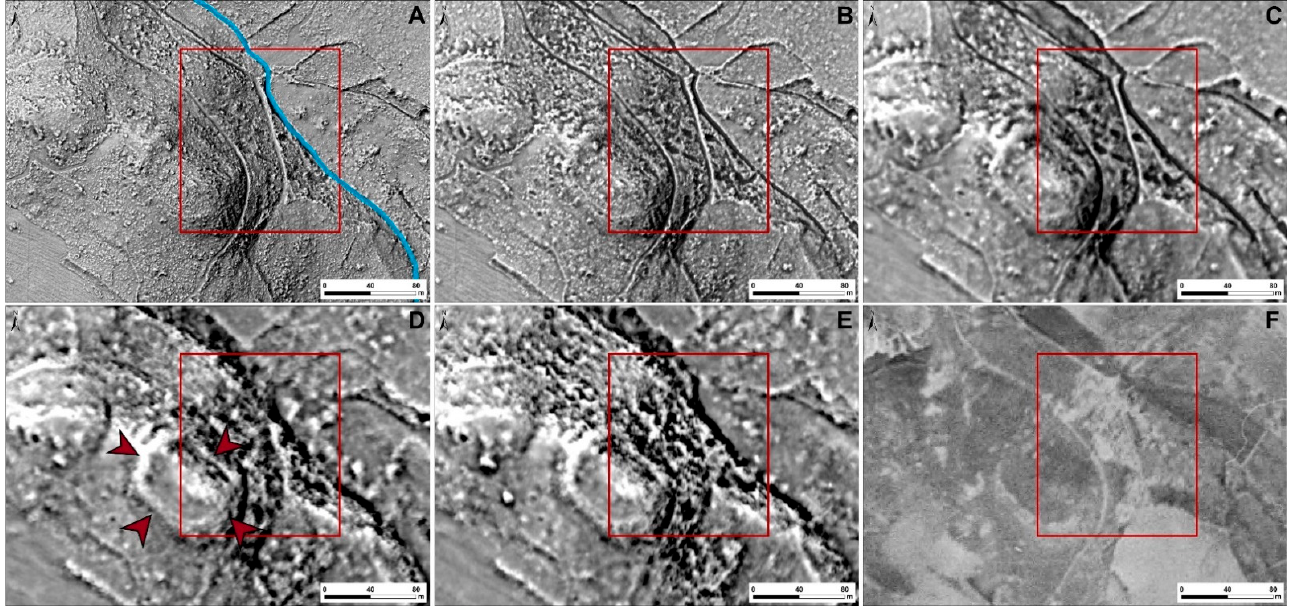
Figure 5. Outeiro de Baltar hillfort with the area explored by the Somar company highlighted (red square). Note the main visible rampart of the hillfort (of near-circular shape depicted in image ( D ) and the mining trenches near the Ferradal stream (the stream is depicted in blue in image ( A ), which affected part of the hillfort. ( A ) A 0.25 m drone-derived local relief model; ( B ) A 0.50 m drone-derived local relief model; ( C ) A 1 m drone-derived local relief model; ( D ) A 1 m IGN-PNOA (2009) local relief model; ( E ) A 1 m IGN-PNOA (2016) local relief model; ( F ) American flight B series of 1956–1957.